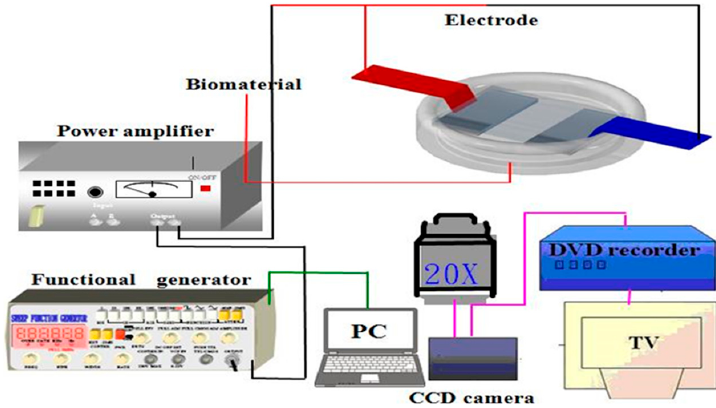
Figure 11. A schematic view of the dielectrophoresis method.